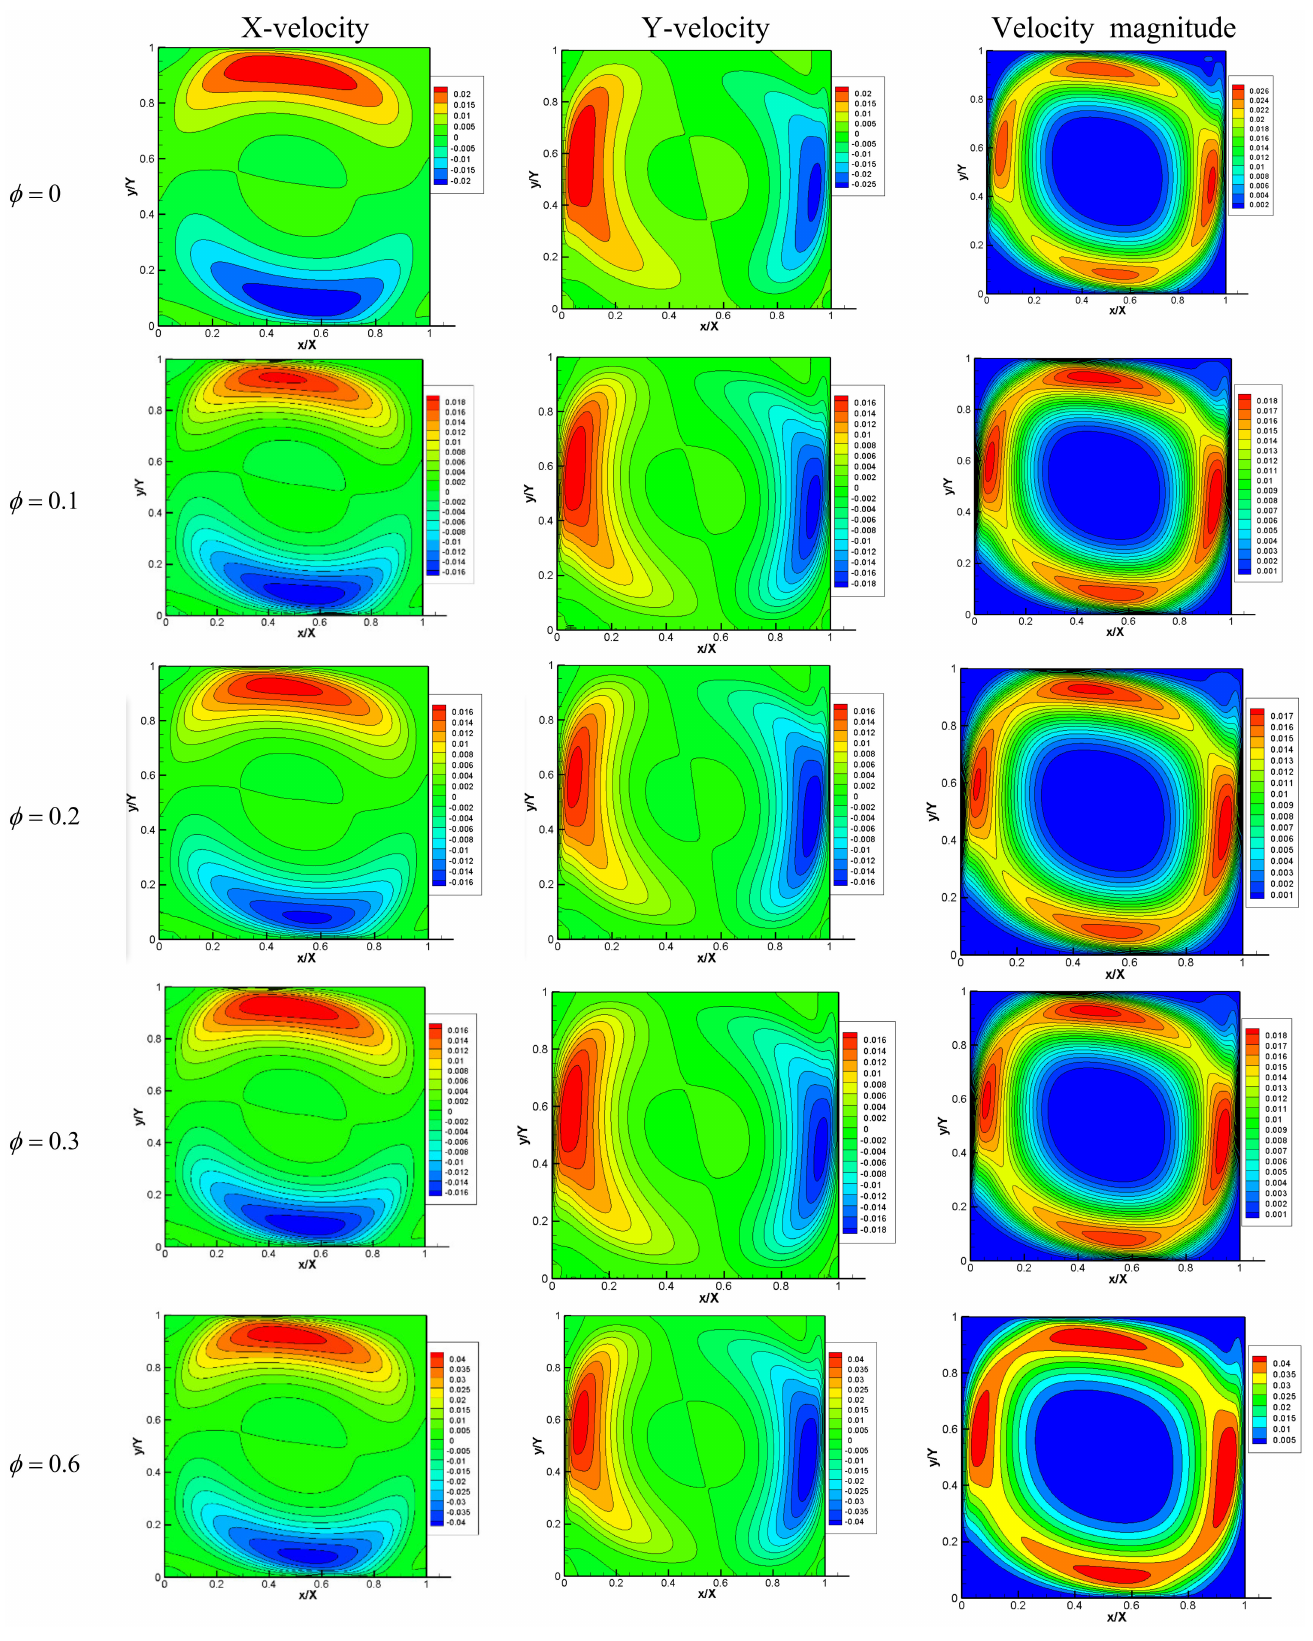
Figure 7. Steady state non-dimensional X-velocity, Y-velocity, and velocity magnitude profile behavior for central partially left boundary conditions (case 1: Dirichlet constant boundary condition) at different volume fractions ( φ ) for Ra = 10 5